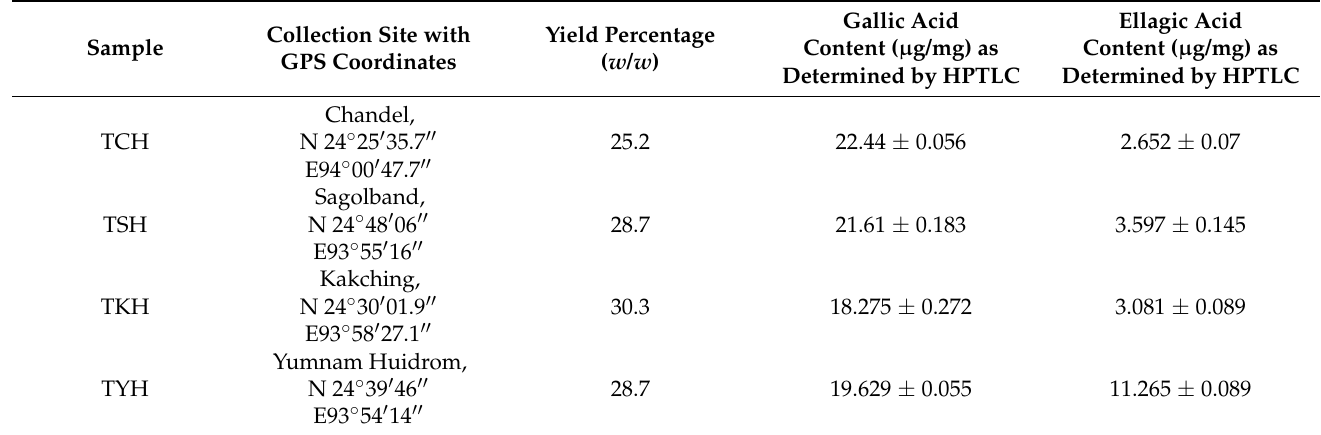
Table 1. Sample name, collection site, % yield of extracts, andcontent ( µ g/mg) of gallic and ellagic acid determined by